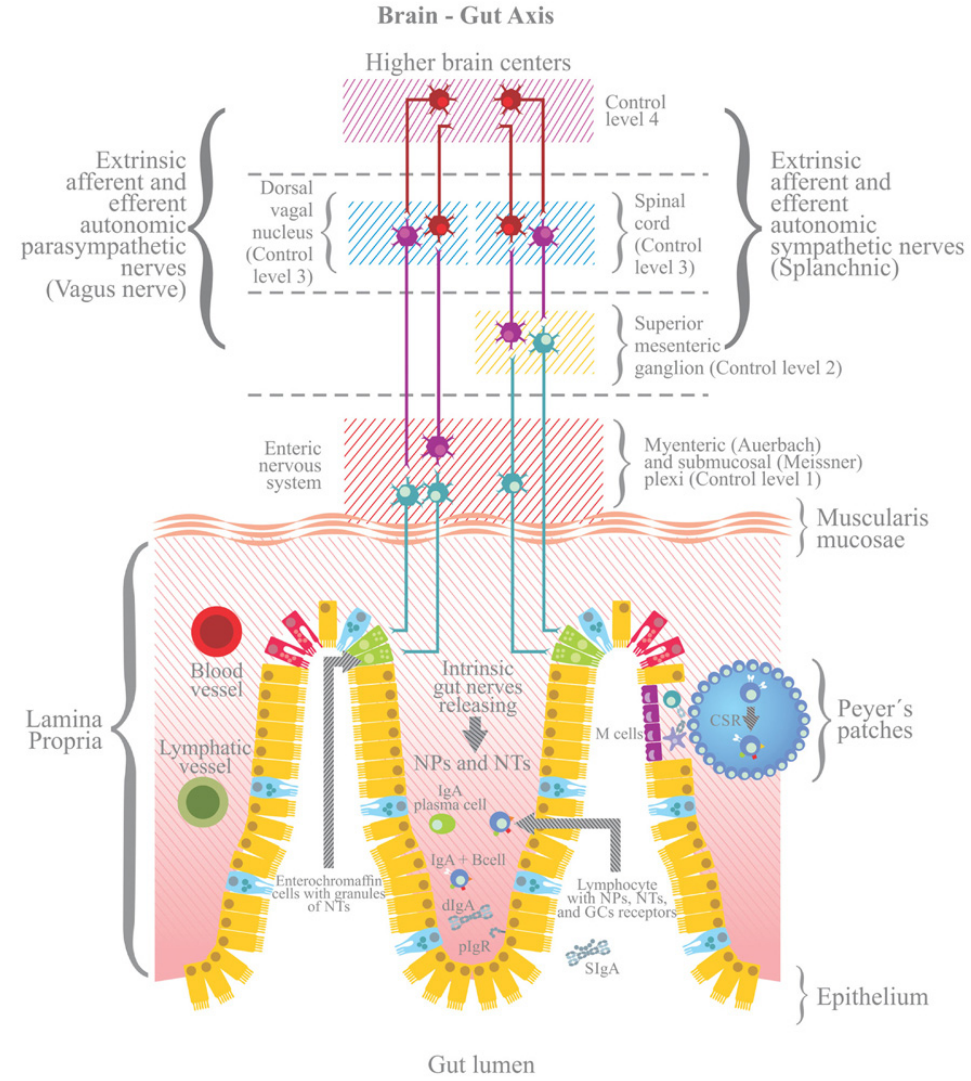
Figure 1. The ENS is connected to the CNS via the sympathetic and parasympathetic pathways, forming the brain–gut axis (BGA) [95]. Four levels for the control of the BGA are shown: activation of the ENS, including afferent and efferent intrinsic intestinal nerves (afferent nerves send signals from the periphery to the brain; efferent nerves from the brain to the periphery); and extrinsic innervations, whether sympathetic (splanchnic) or parasympathetic (vagus nerve) influences the generation of dIgA and/or the pIgR-mediated trancytosis. NTs, neurotransmitters; NPs, neuropeptides; GCs, glucocorticoids. Epithelial cell types: blue, enterochromaffin cells; green, neuroendocrine cells; red, Paneth cells; yellow, enterocytes.